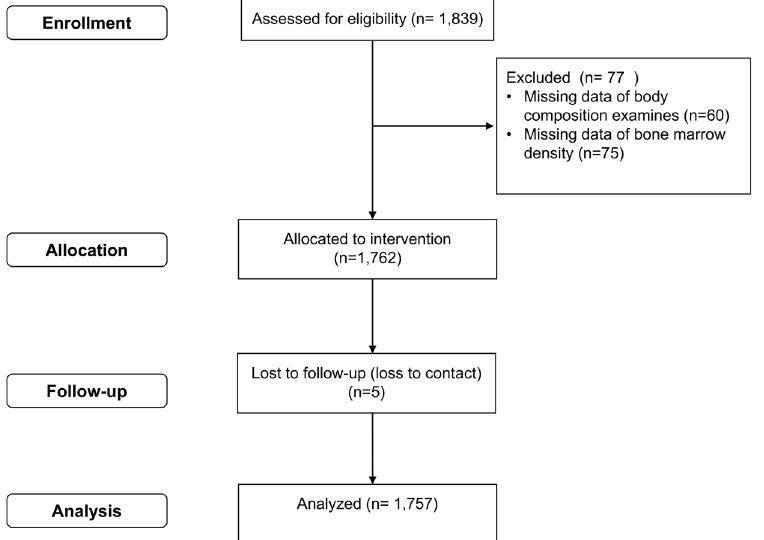
Figure 4. Participants derived from I-Lan Longitudinal Aging